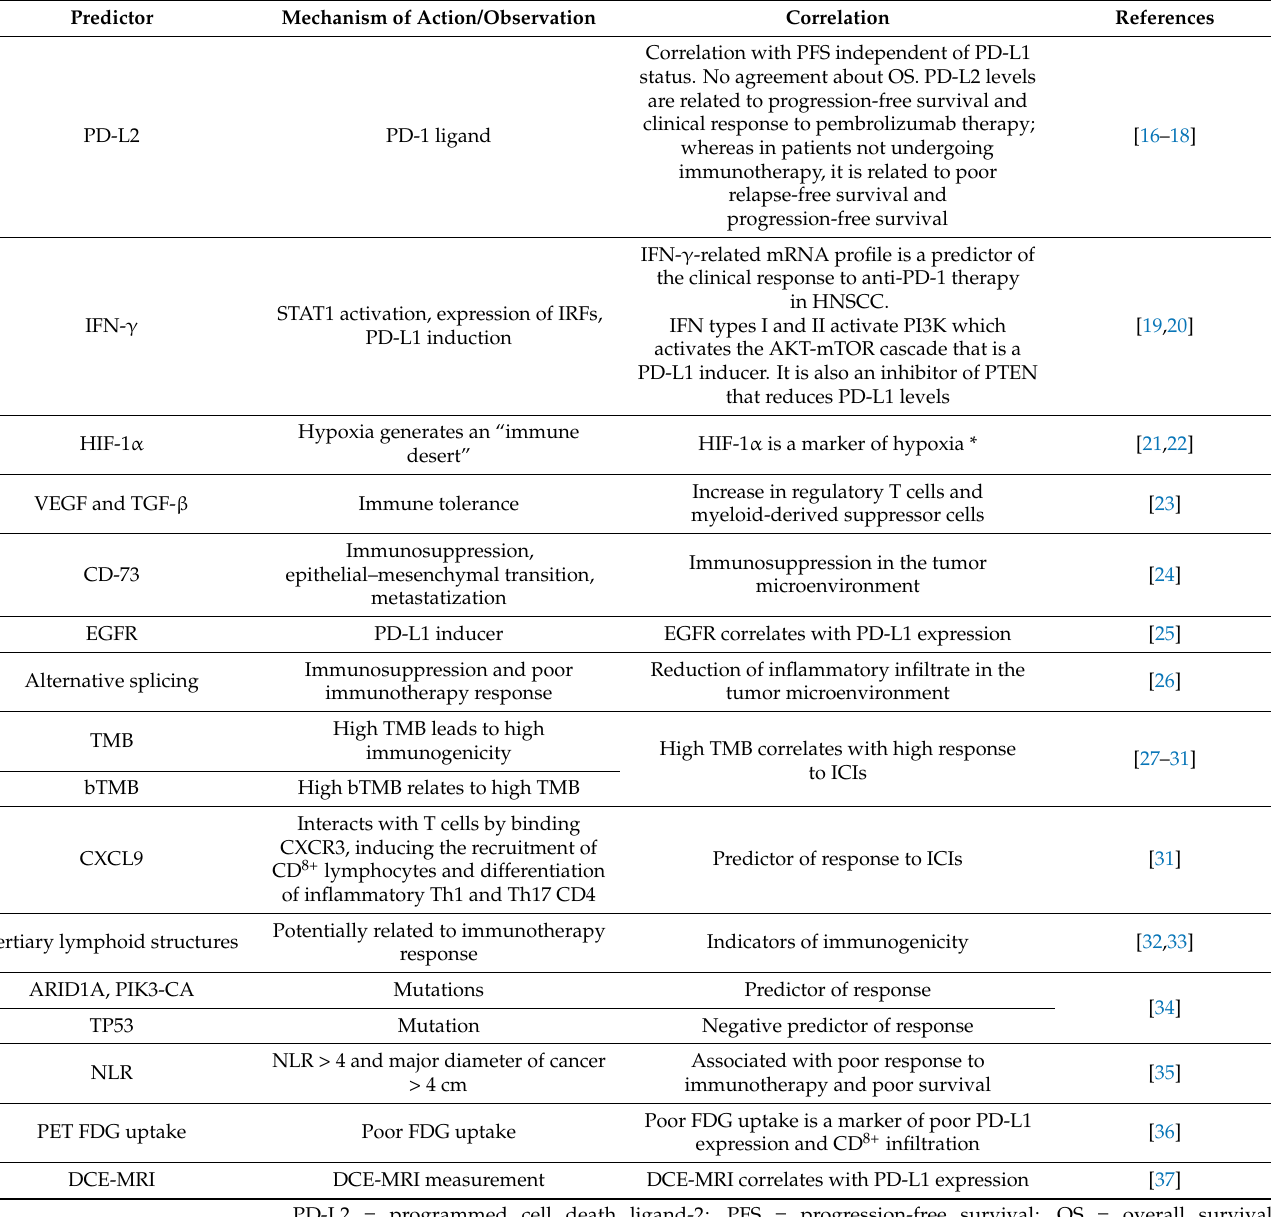
Table 1. Diagnostic predictors of anti-PD-1/PD-L1 immunotherapy response in